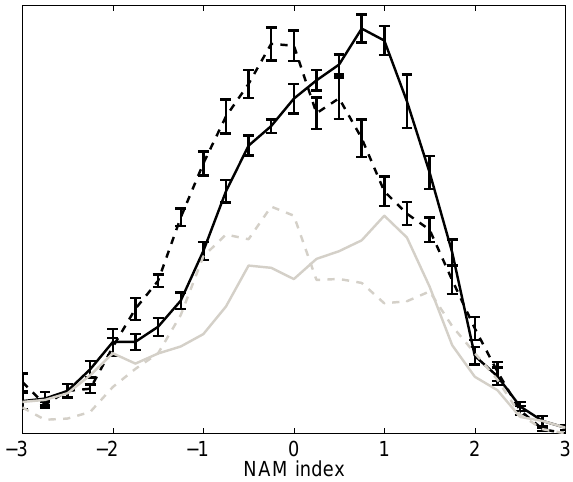
Fig. 11. NAM index histogram for the altitude region 10hPa– 200hPa for DJF. Solid black: S-EPP, dashed black: S-noEPP. The error bars show the standard deviation calculated from the individ- ual years. The grey lines show the analogous results for only those years where no SSWs